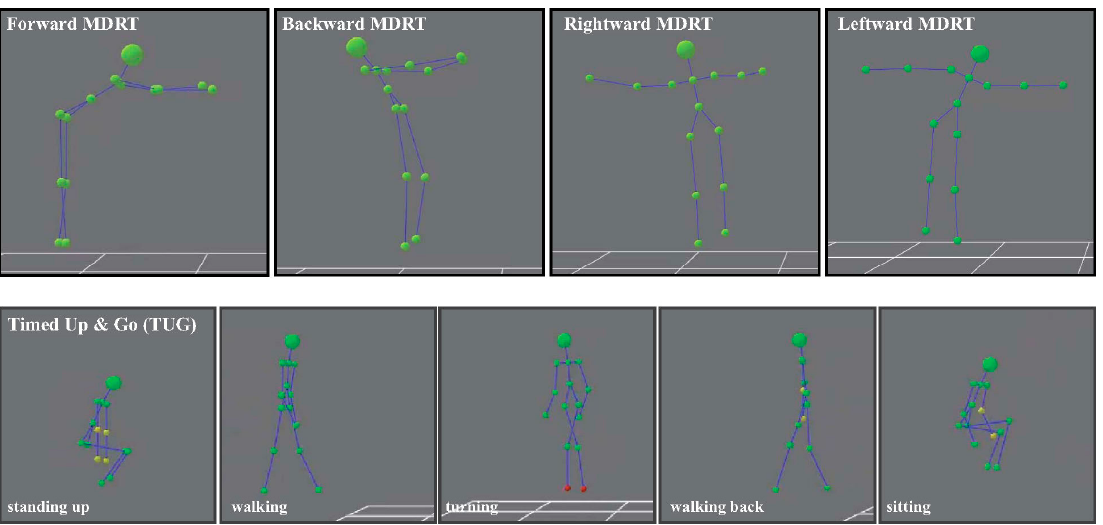
Figure 3. Skeleton’s movement detected in the MDRTs and the TUG test.